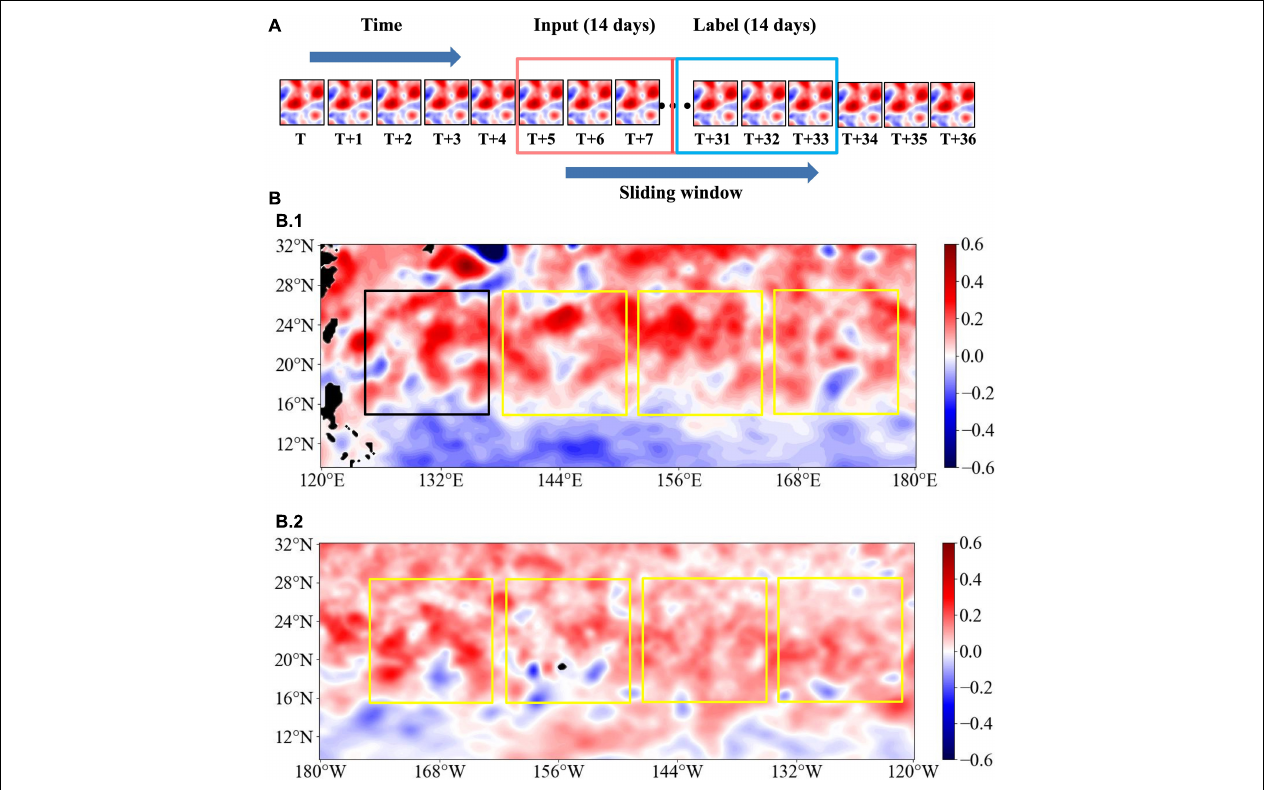
FIGURE 5 | Data segmentation and augmentation for SLA time series. (A) Segmentation with sliding window. (B) Augmentation of SLA time series for transfer